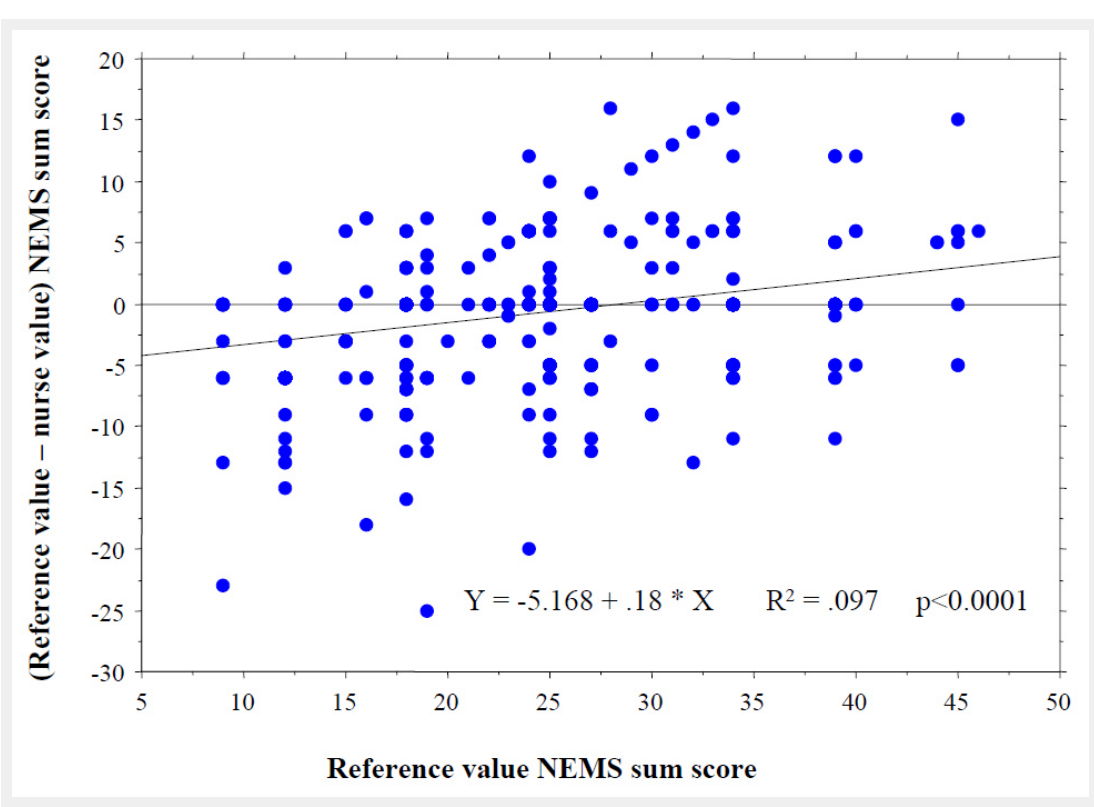
Figure 1 Linear regression between the difference (reference value – nurse value) of the NEMS sum-score and the mean NEMS sum-score [(reference value + nurse value) x